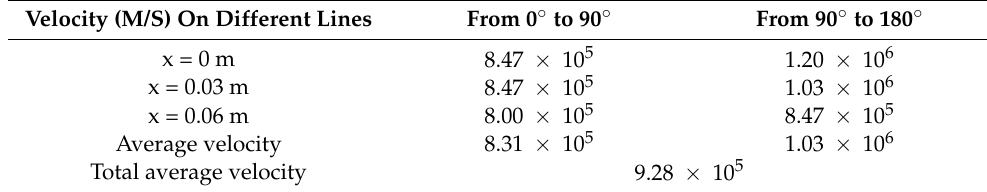
Table 1. Average velocities of H z ( x , z , t )